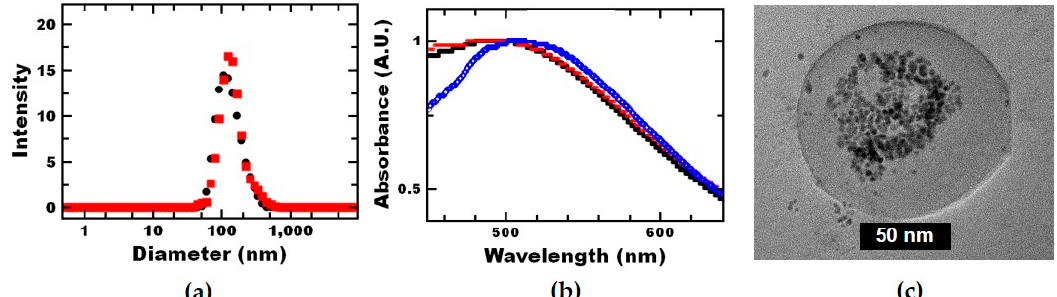
Figure 1. Polymer nanoreactors were fabricated via self-directed assembly. ( a ) DLS confirms the uniform size distribution of the ~130 nm self-assembled polymer nanoreactors (black circles) and confirms that the size is the same after the reduction of 4-nitrophenol (red squares). ( b ) UV-vis analysis shows that the absorbance of the gold nanoparticle remains unchanged through the solvent switch from toluene (black filled circles) to tetrahydrofuran (THF) (red open circles). A red-shift is seen upon encapsulation within polymer nanoreactors (blue open diamonds) due to close proximity of the encapsulated gold nanoparticles. ( c ) TEM imaging demonstrates that multiple gold nanoparticles were encapsulated within the core of the nanoreactors.